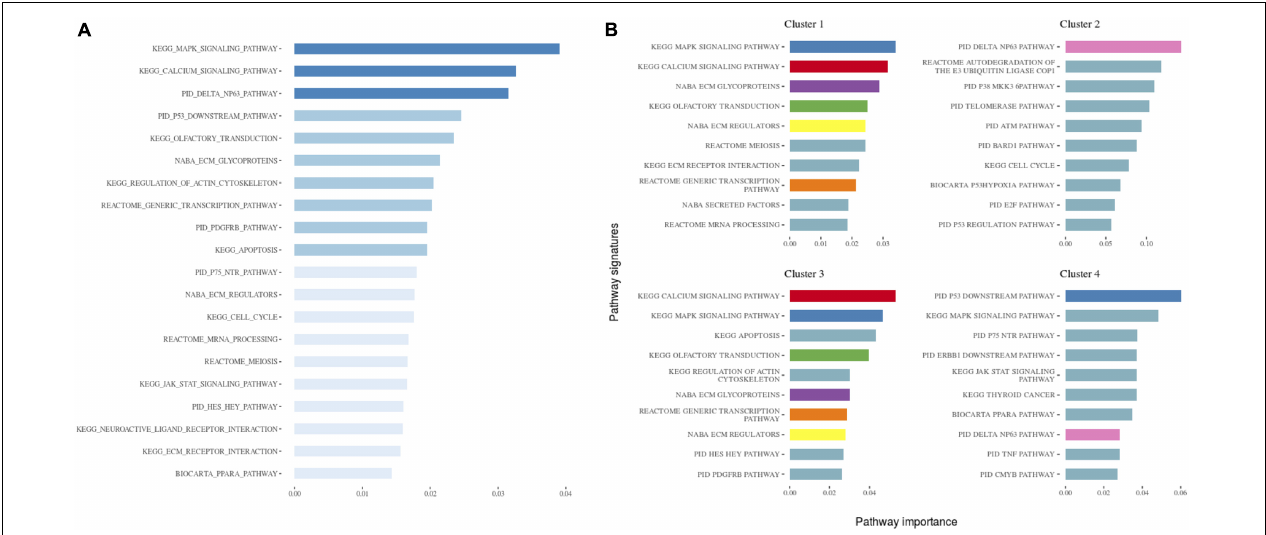
FIGURE 3 | (A) The 20 most important pathways for the classification model predicting the identified clusters. There were 84 pathways in the model altogether. Shades of blue represent clustered pathway signatures that have similar importance values. (B) The 10 most important pathways characterizing individual clusters of the classification model. Pathway importance was ranked by its information gain, which corresponds to the relative contribution of the pathway to a prediction. The first word in a pathway name denotes a database from which it originates. Pathways shared between clusters are